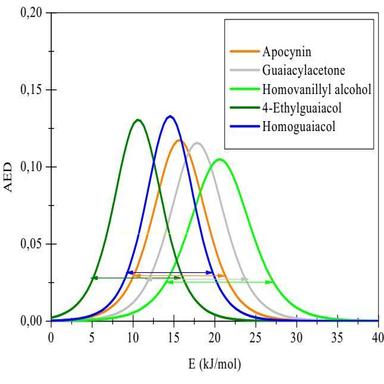
Adsorption energy distributions (AEDs) of the mouse eugenol olfactory receptor mOR-EG.